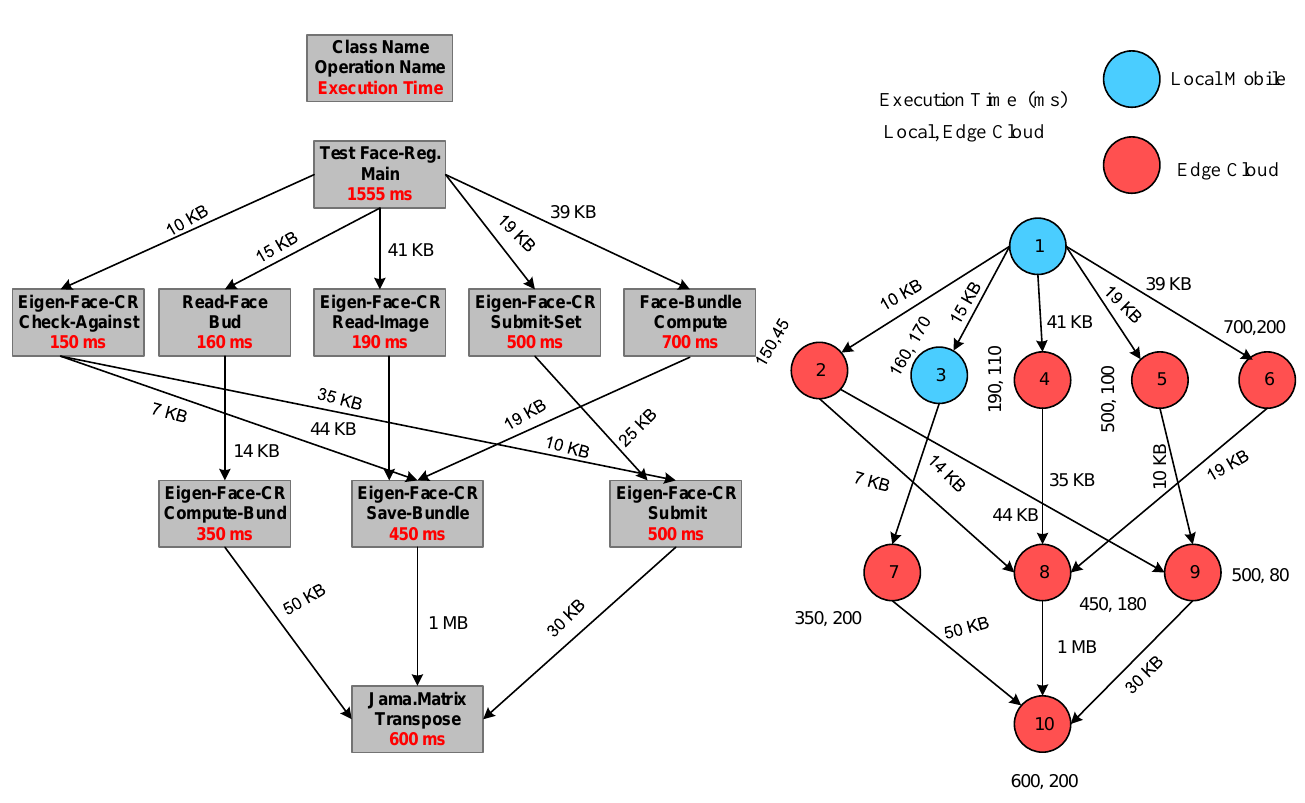
Figure 6. Application Partitioning Results After Applying Algorithm